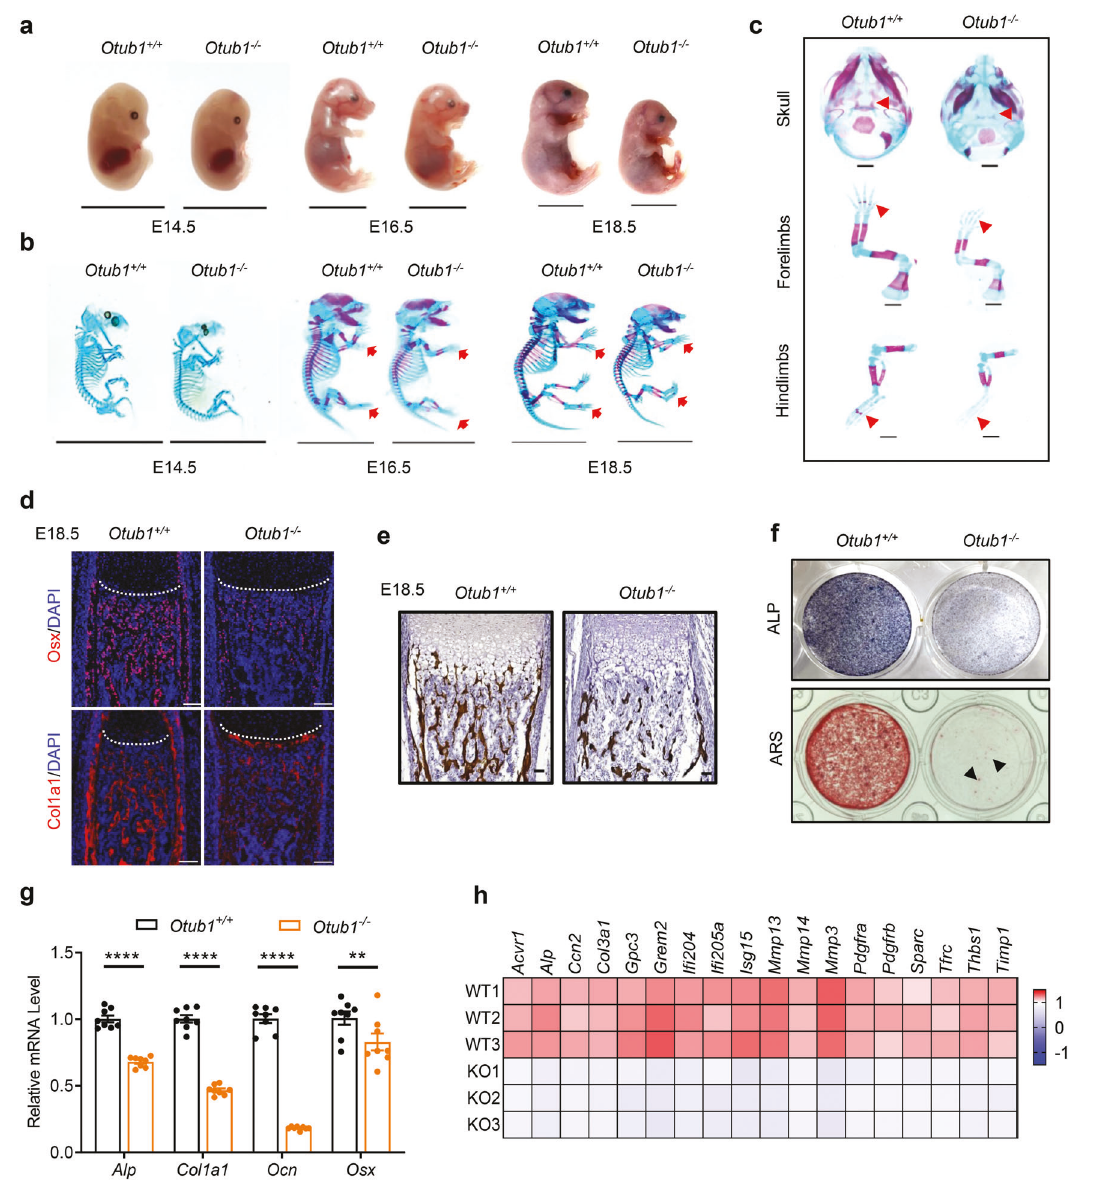
Fig. 1 OTUB1 de fi ciency causes defects in osteogenesis. a Representative image of Otub1 + / + and Otub1 − / − embryos at E14.5, E16.5, and E18.5. n = 4 per group. Scale bars, 1 cm. b Representative images of whole skeleton of Otub1 + / + and Otub1 − / − embryos at E14.5, E16.5, and E18.5. Red arrows indicate the delayed Alizarin red staining in the ribs and phalanges. n = 4 per group. Scale bars, 1 cm. c Representative images of skeleton of skulls, forelimbs, and hindlimbs in E16.5 Otub1 + / + and Otub1 − / − embryos. Red arrows indicate the delayed Alizarin red staining. n = 4 per group. Scale bars, 1 mm. d Immuno fl uorescence assay for expression of osteoblast differentiation markers Osx and Col1a1 in E18.5 Otub1 + / + and Otub1 − / − femurs. n = 3 per group. Scale bars, 100 μ m. White line indicates the epiphyseal growth plate. e Representative images of Von Kossa staining of E18.5 Otub1 + / + and Otub1 − / − mice. n = 3 per group. Scale bars, 50 μ m. f Representative images of ALP and ARS staining of osteoblast cells from E18.5 Otub1 + / + and Otub1 − / − mice after cultured in osteogenic medium for 14 and 28 days. Black arrows indicate calci fi ed nodules. g Quantitative RT-PCR analysis of osteogenesis genes mRNA levels in osteoblast cells from Otub1 + / + and Otub1 − / − mice. n = 8 per group. h Gene expression pro fi les of the selected osteogenetic genes in osteoblast cells from Otub1 + / + (referred to as WT) and Otub1 − / − (referred to as KO) mice. **p < 0.01, ****p < 0.0001. All data are shown as the mean ± fi broblast colony-forming unit (CFU-F) (Supplementary Fig. 2m) cranial bones of Otub1 + / + (WT) and Otub1 − / − (KO) mice. A total of between OTUB1 CTRL and CKO groups. Collectively, these results 504 downregulated genes (<0.5-fold) and 301 upregulated genes indicate that osteoblast-speci fi c OTUB1 is essential for osteogenic (>2-fold) genes were identi fi ed in OTUB1-de fi cient osteoblasts differentiation and mineralization. (Supplementary Fig. 3a). Next, we used these differentially expressed genes for further gene ontology (GO) analysis (Fig. 3a). Given that OTUB1 was involved in organogenesis, OTUB1 stabilizes FGFR2 through inhibiting degradative detailed KEGG pathway analysis was focused on GO terms related polyubiquitin chains to the development process. KEGG pathway assessment revealed To uncover the potential mechanism of OTUB1 in regulating that PI3K-Akt and MAPK signaling pathways were the top 2 osteogenesis, we performed RNA-seq using osteoblasts from the